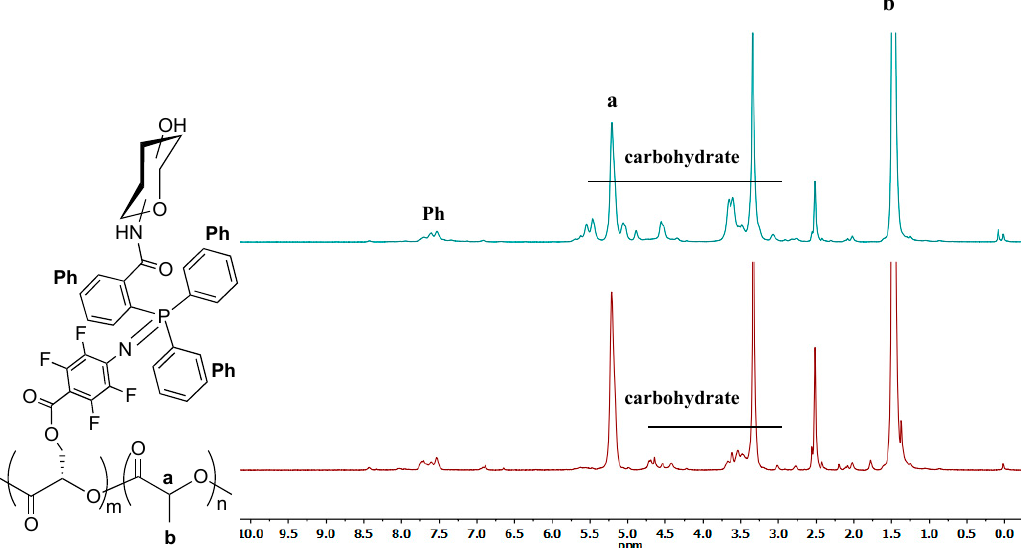
Figure 3. 1 H ‐ NMR spectra of Man ‐ and MH ‐ grafted copolymers 10 ( top ) and 11 ( bottom ) in DMSO ‐ d 6 .